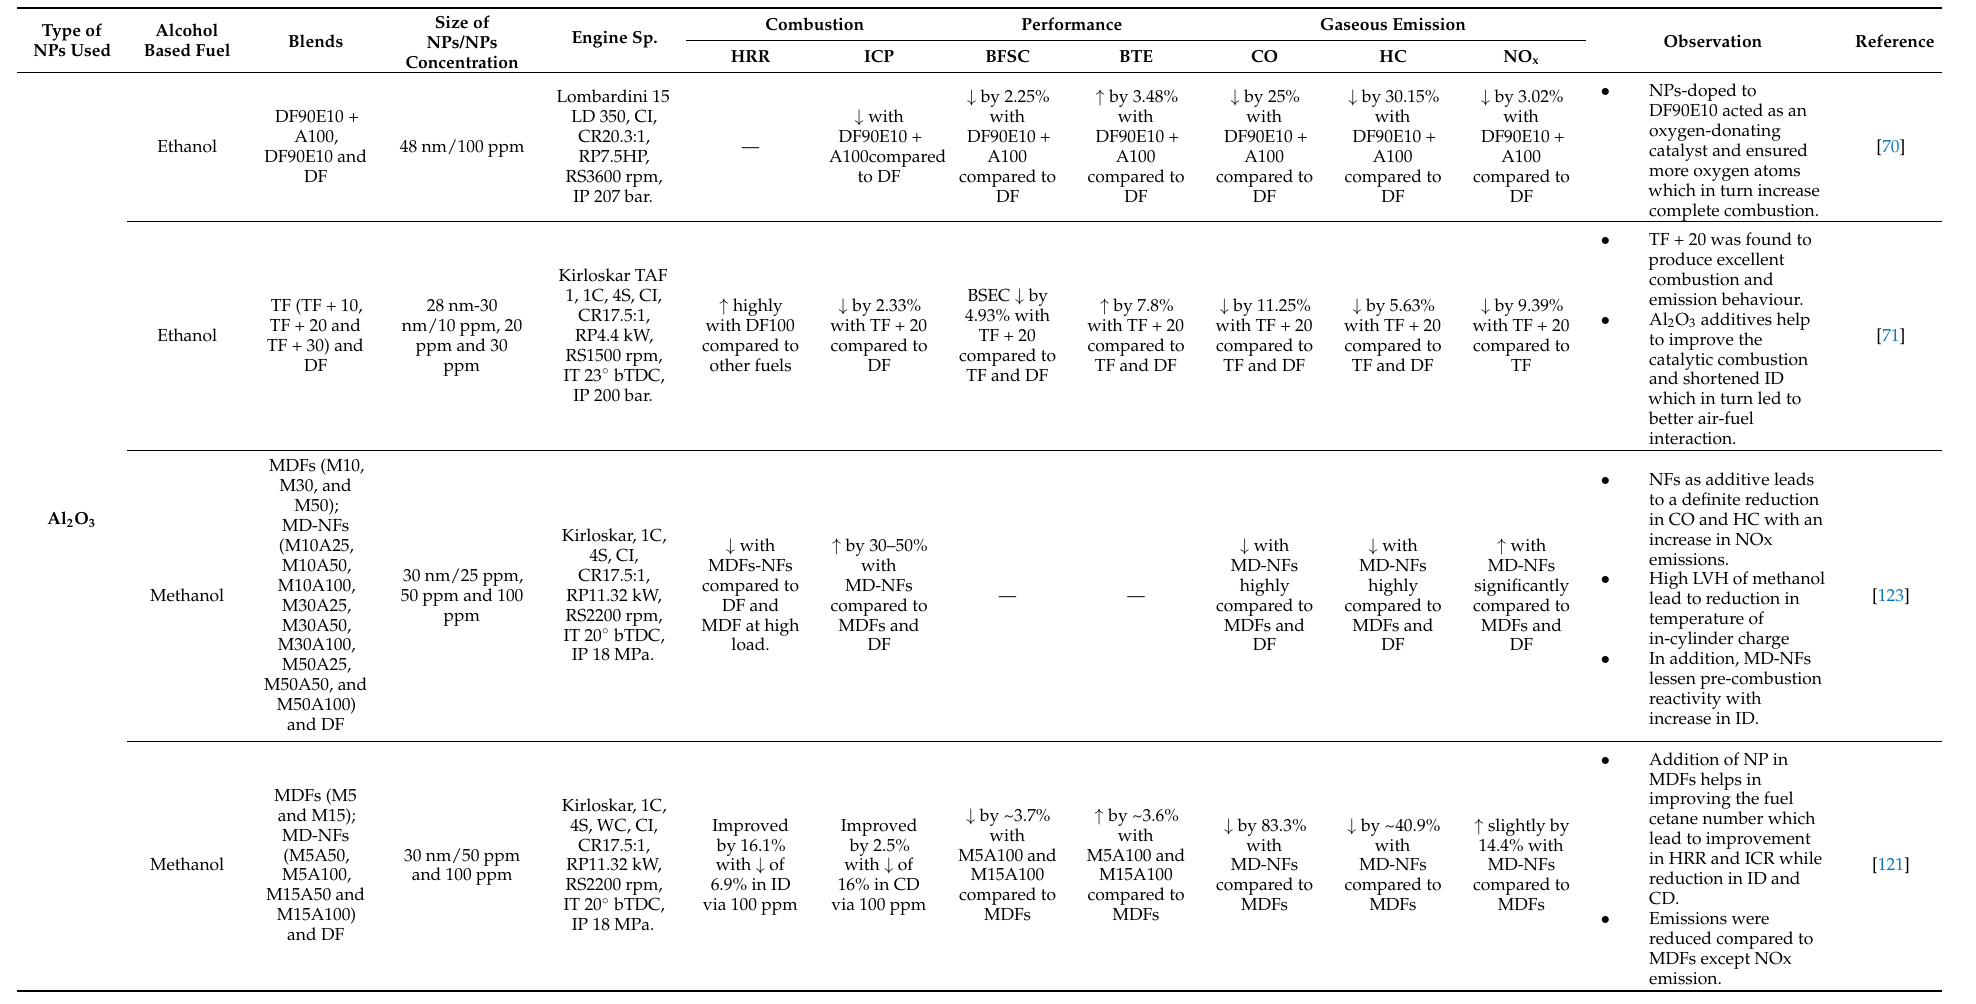
Table 4. Summary of the most recent experiments on different nanoparticles addition in alcohol fuels used in CI